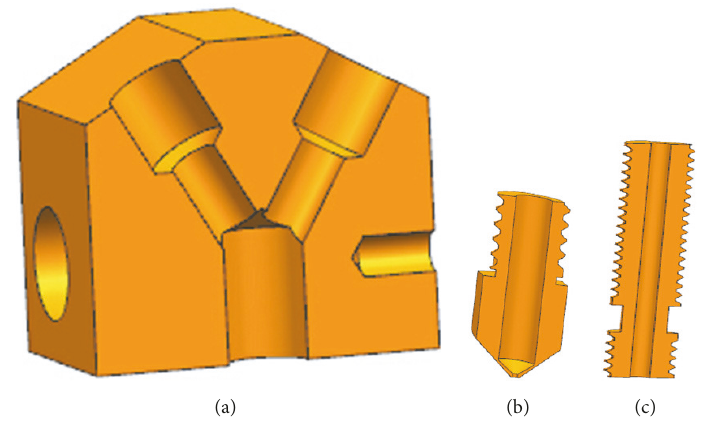
Figure 3: Simplified model of (a) heating block, (b) nozzle, and (c) throat pipe.